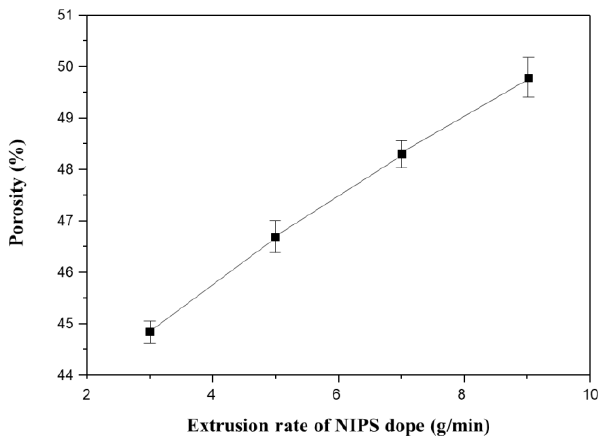
Figure 13. The variation of porosity as a function of extrusion rate of NIPS dope solution in the dual layer hollow fiber (Sample 2#N): Fixed at TIPS extrusion rate 17 g/min and at bore extrusion rate 6 g/min.